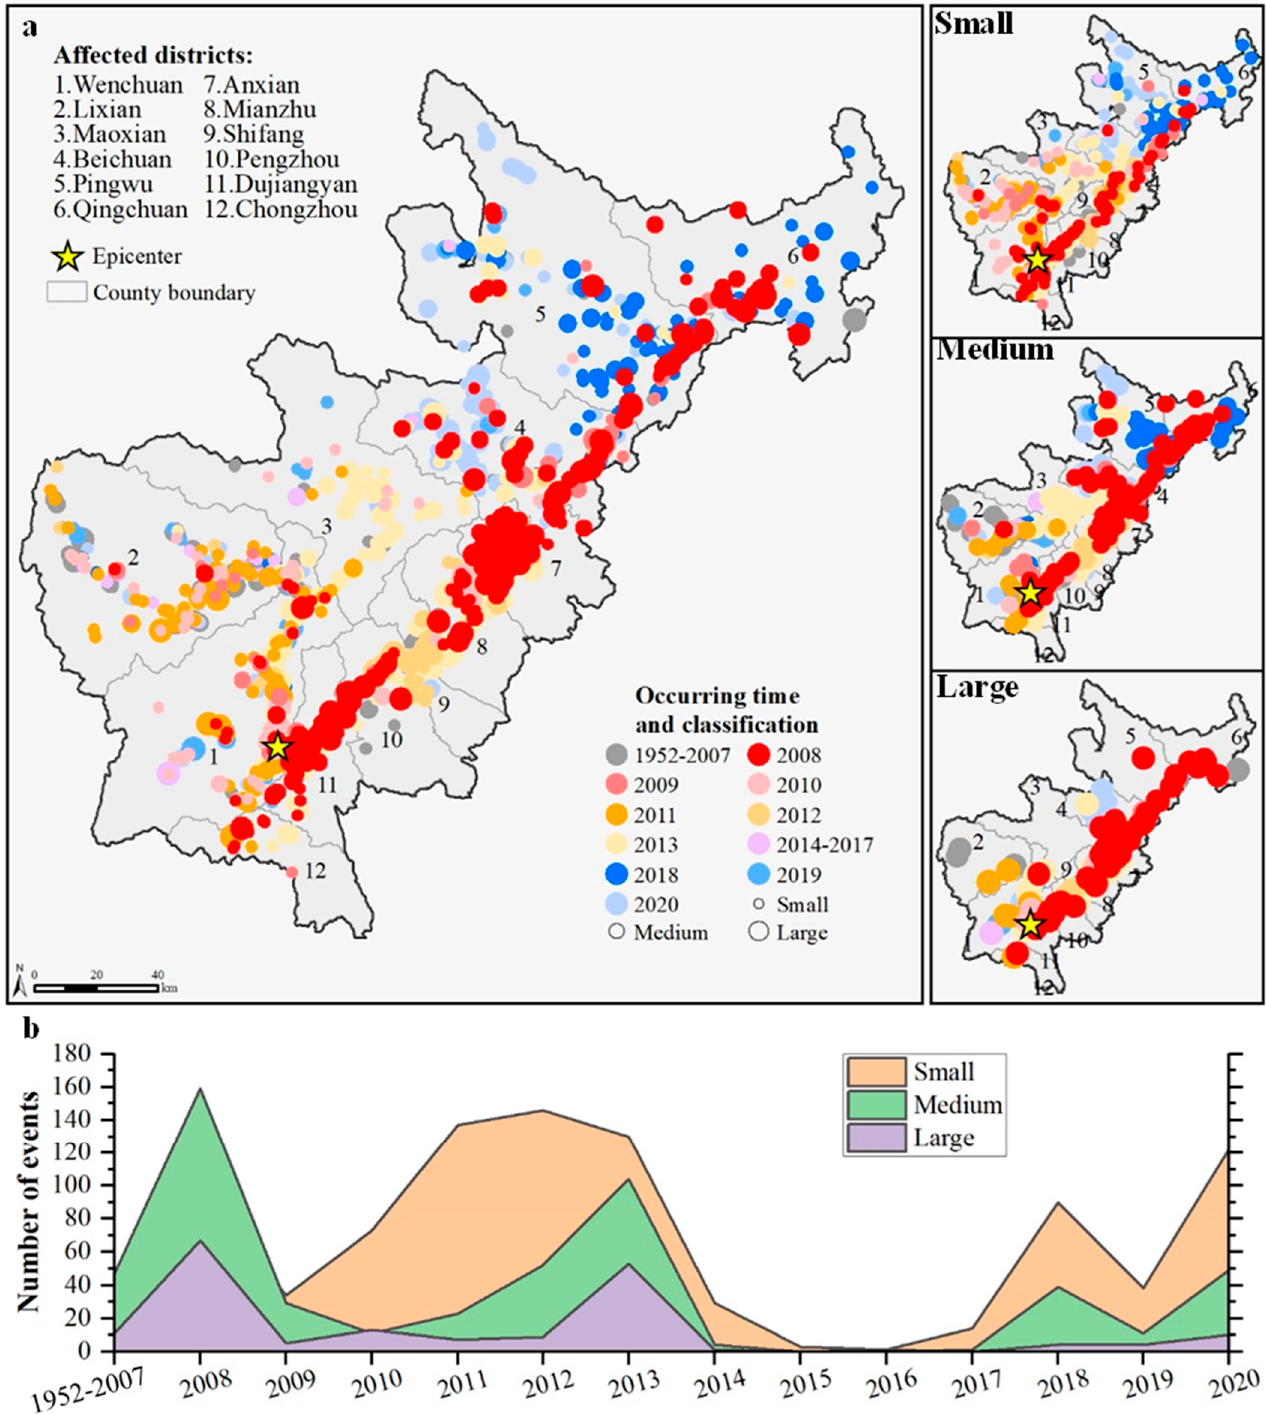
Figure 5. Spatial and temporal distribution of debris flow events of each scale. ( a ) Distribution maps of small to large debris flow events. ( b ) Statistical curves for small to large debris flow